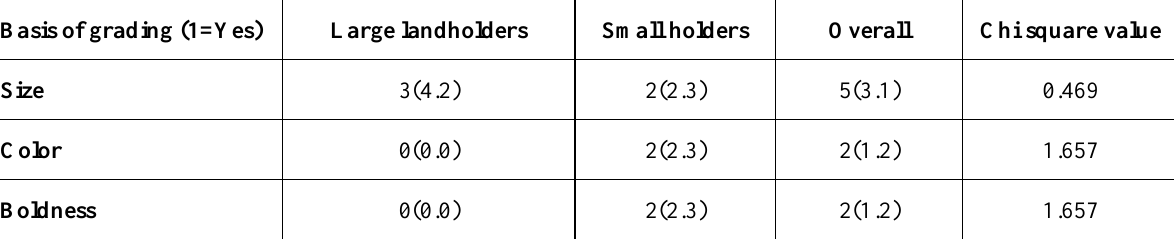
Table 7. Basis of grading of large